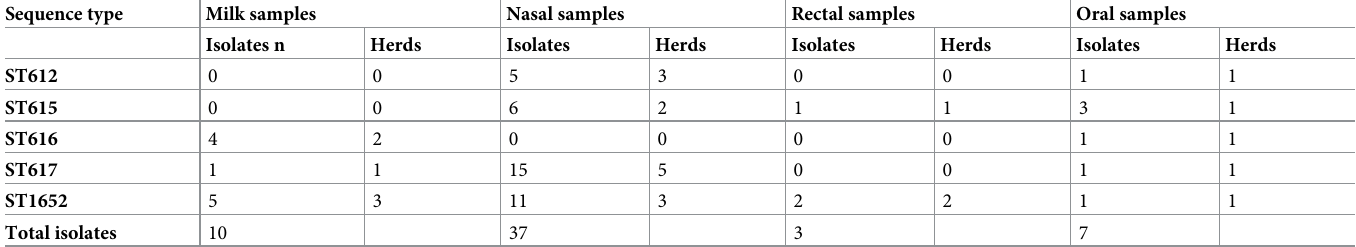
Table 3. Distribution of sequence types (STs) of Group B Streptococcus (GBS) isolated from camel milk and extramammary body sites collected from six herds in Laikipia County, Kenya, November 2019. Sequence